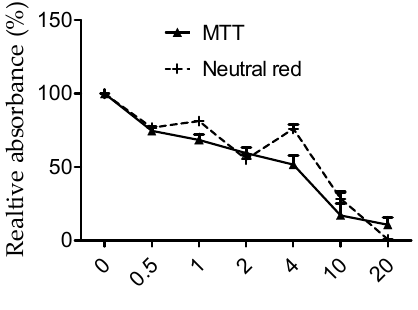
Figure 5. Staurosporin-induced apoptosis in ARPE-19 cells. Cells were treated with di ff erent concentrations of staurosporin before evaluating metabolic activity (MTT) and cell viability (neutral red). Results are expressed as mean % ± SEM ( n = 4–5 independent experiments).